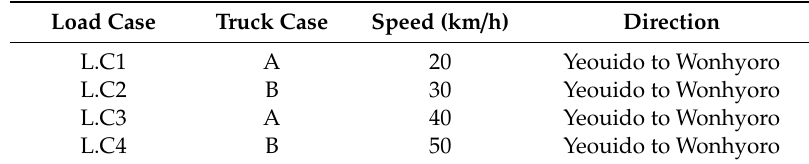
Figure 5. Test Truck axle dimension (units in m). Table 2. Dynamic load test.